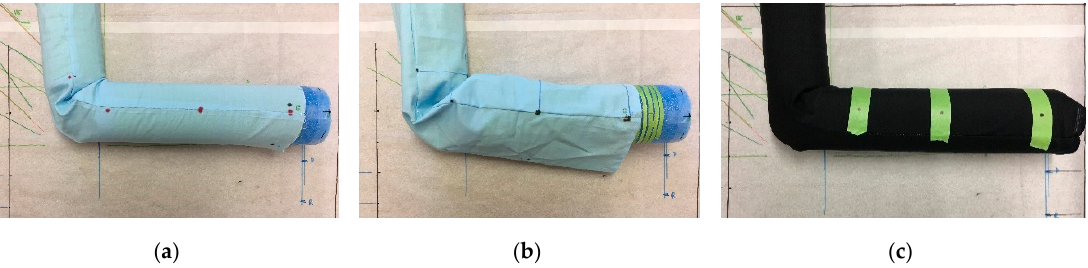
Figure 1. In vitro experimental setup of the three kinds of test sleeves, fitted around the Styrofoam arm: ( a ) Tight inelastic sleeve, ( b ) loose inelastic sleeve, and ( c ) stretchy sleeve.